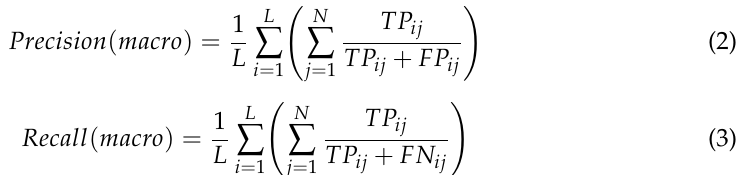
Table 1. Results for different combinations of baseline, iADRGSE, and iADRGSE features. Features Set